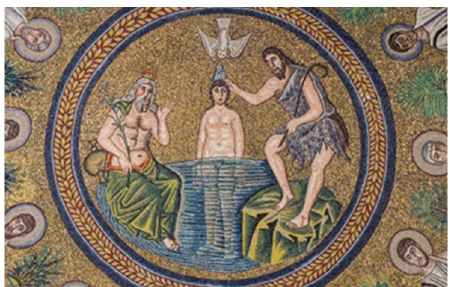
Figure 3. Baptism of Christ, mosaic, fifth century, Arian Baptistery, Rome. Photograph: https://www.flickr.com/photos/paullew/11904056613 (accessed on 12 May 2020).